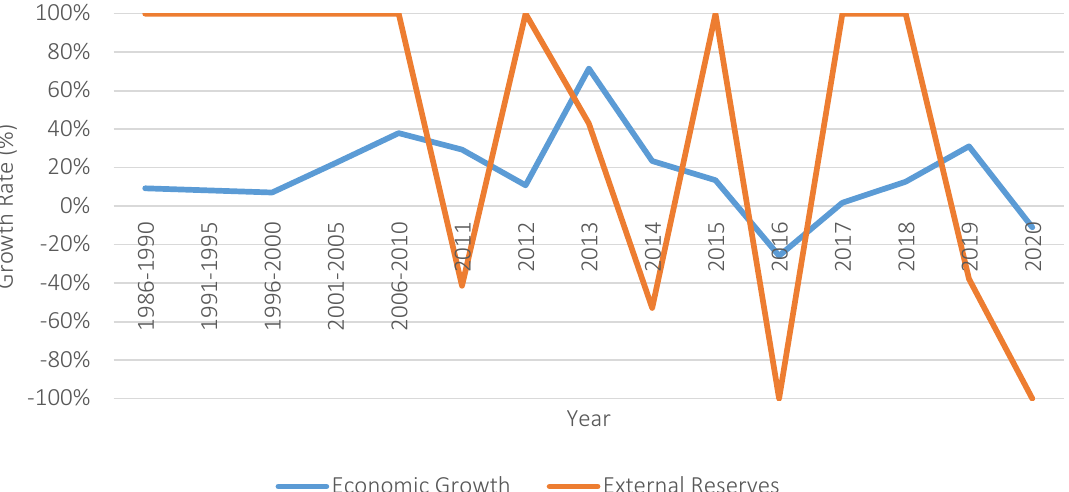
Figure 1. Dynamics of external reserves and economic growth in